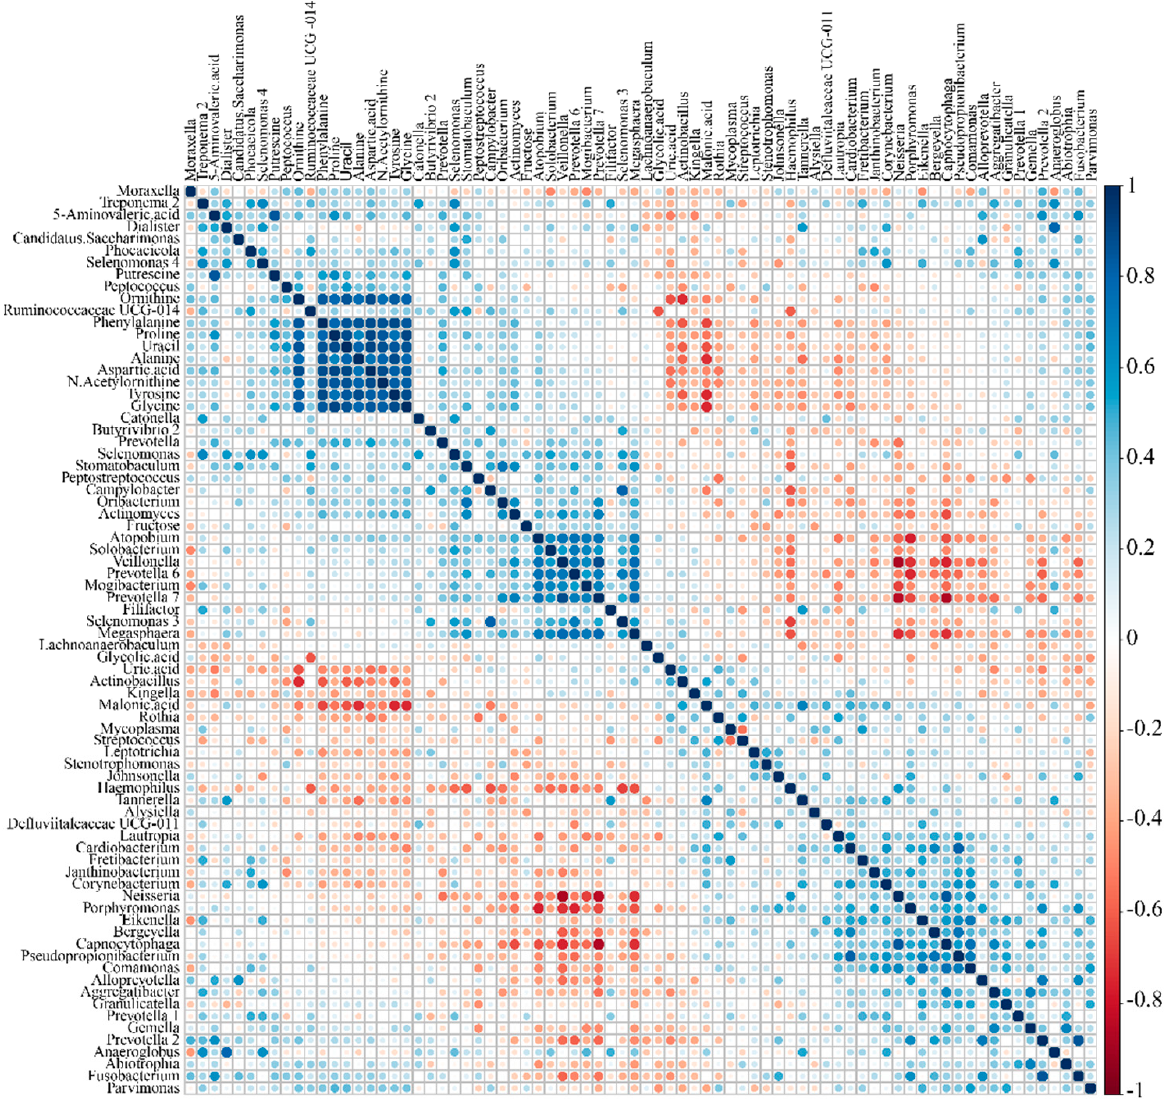
Figure 4. Heat map derived from correlation between the identified metabolites and microbiota in saliva